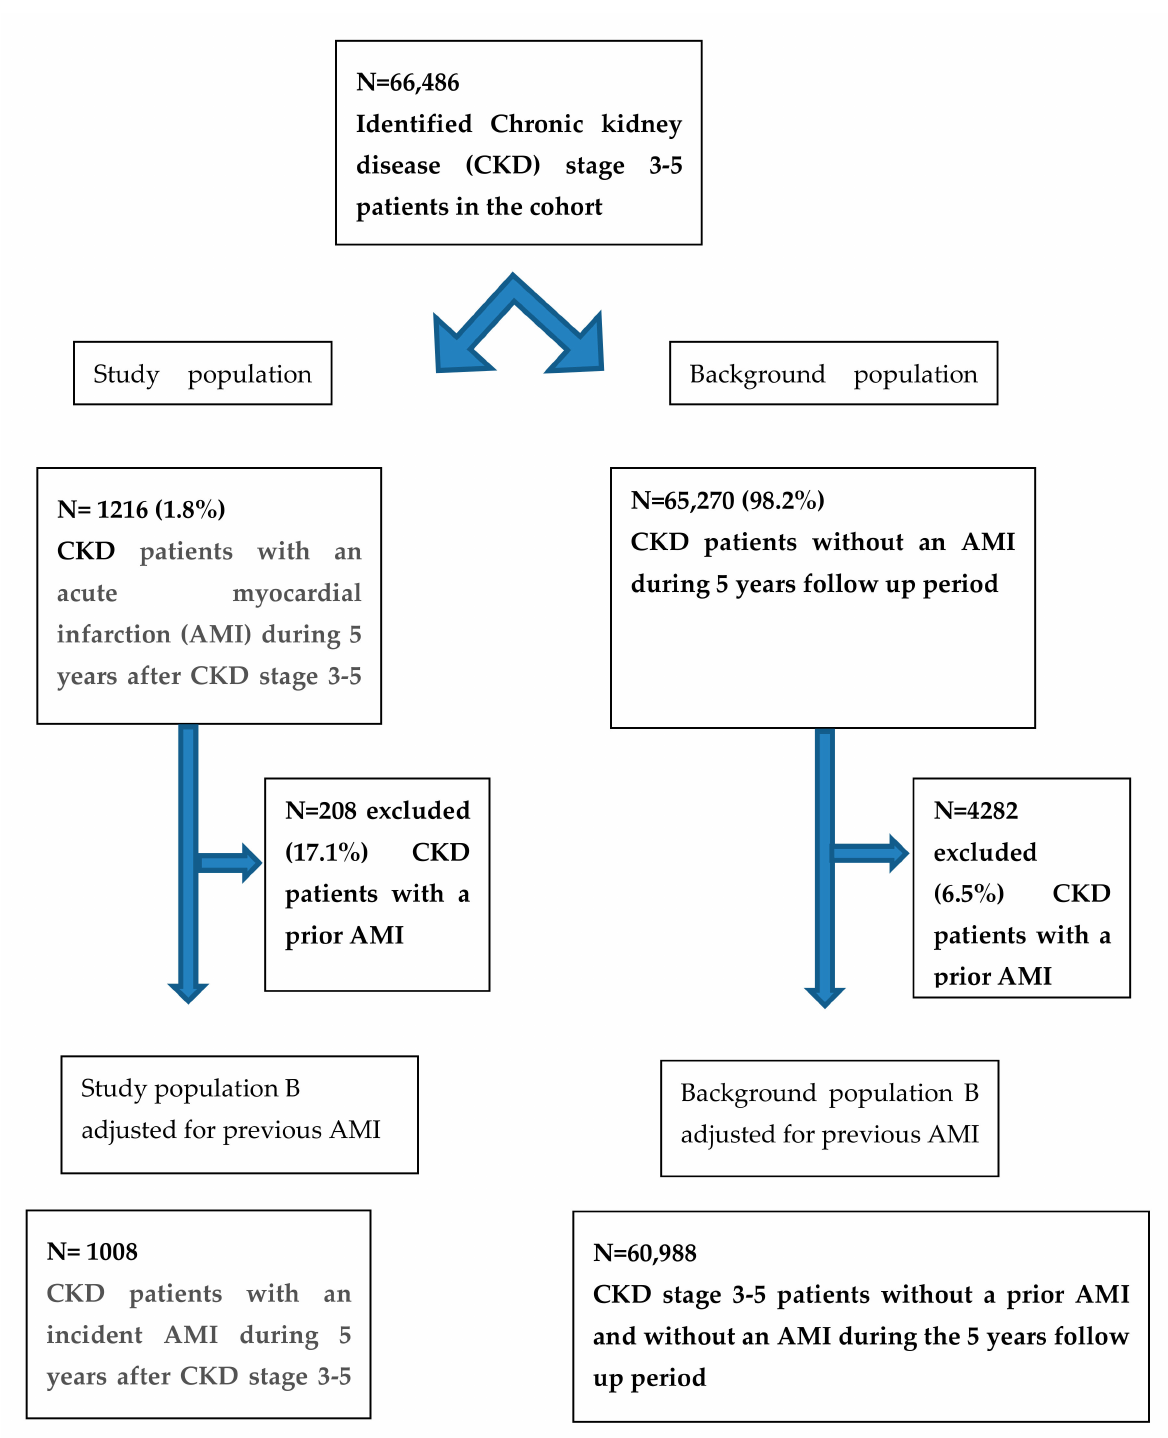
Figure 1. Flow chart showing the selection procedure for the study populations and background populations A and